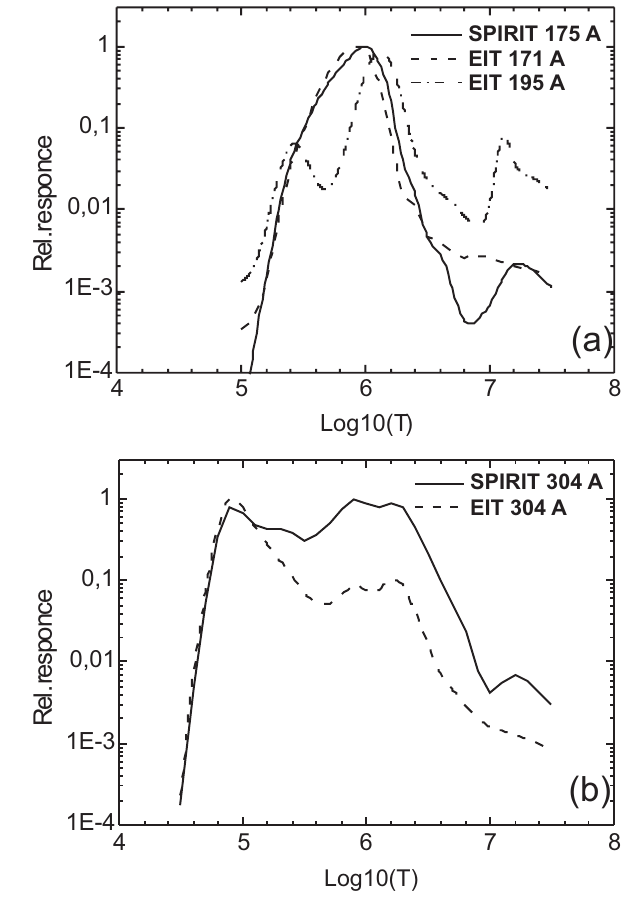
Fig. 2. Plasma temperature response functions for the SPIRIT 175 ˚A channel (a) and the 304 ˚A channel (b) compared with the functions for the corresponding EIT channels 171/195 and 304